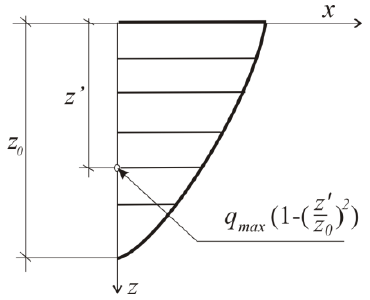
Figure 4. Parabolic change of the heat source in relation to depth.